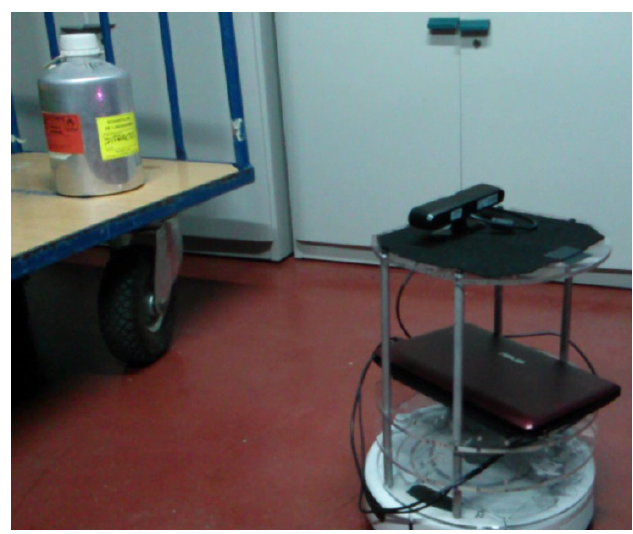
Figure 18. Moving robot and detecting